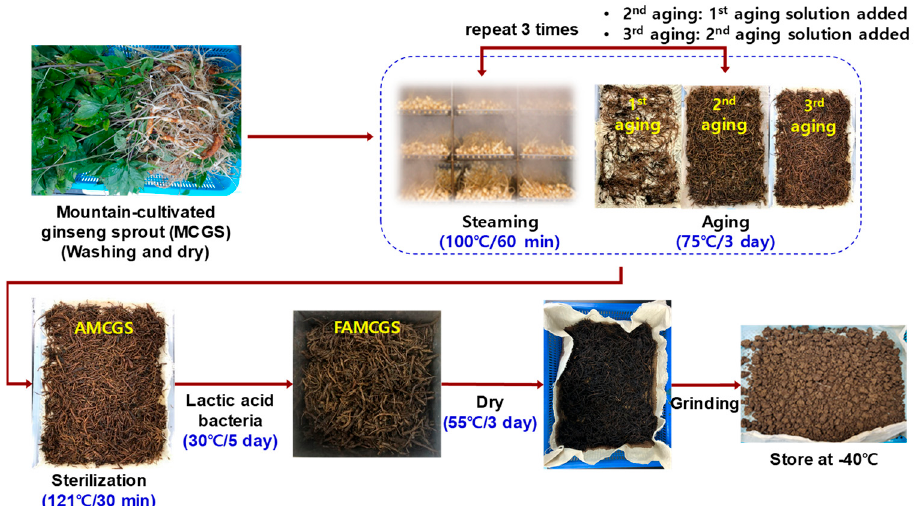
Figure 1. Photographs showing the production process from MCGS to FAMCGS. AMCGS, aged mountain-cultivated ginseng sprout; FAMCGS, fermented and aged mountain-cultivated ginseng sprout.